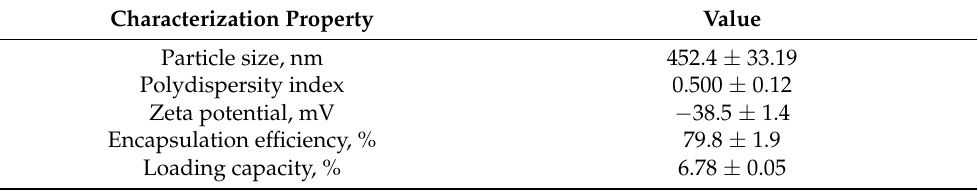
Table 2. Characterization of the selected GSH-Loaded Nanostructured Lipid Carriers (GSH-NLCs). Characterization